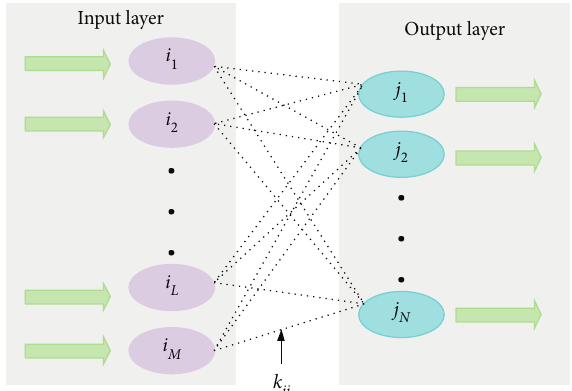
Figure 1: Self-organizing competition network model in drug relationship